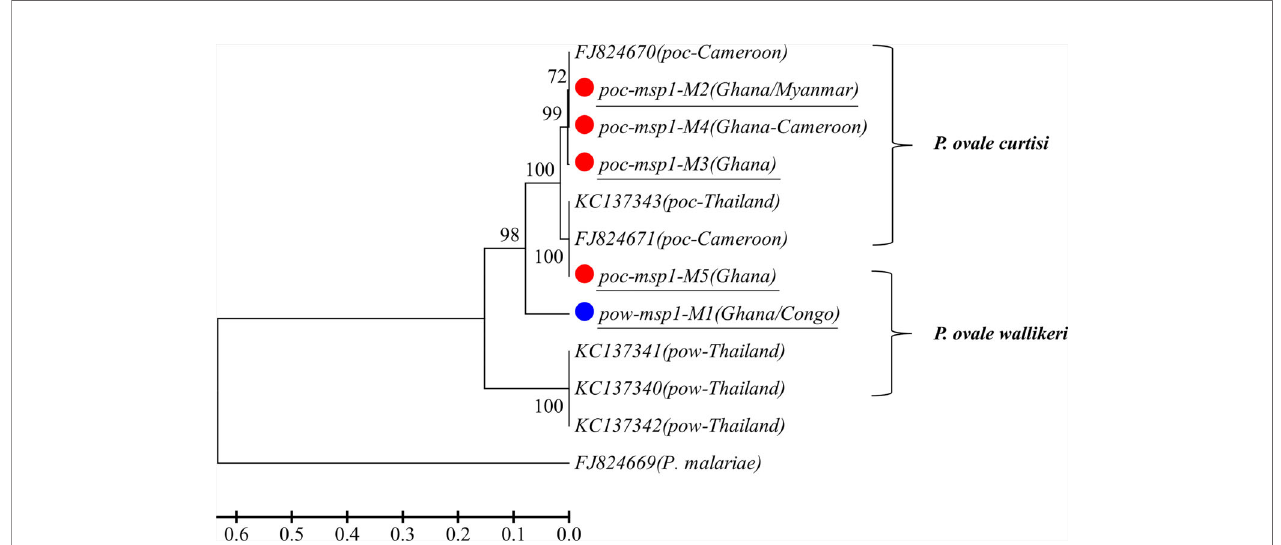
FIGURE 3 | Phylogenetic tree analysis of msp1 haplotypes (M1 – M5) determined by amplicon deep sequencing in P. ovale . poc , P. ovale curtisi ; pow , P. ovale wallikeri. P. malariae is used as outgroup. Color mark represents haplotypes identi fi ed in this study. The novel haplotypes show the underlined